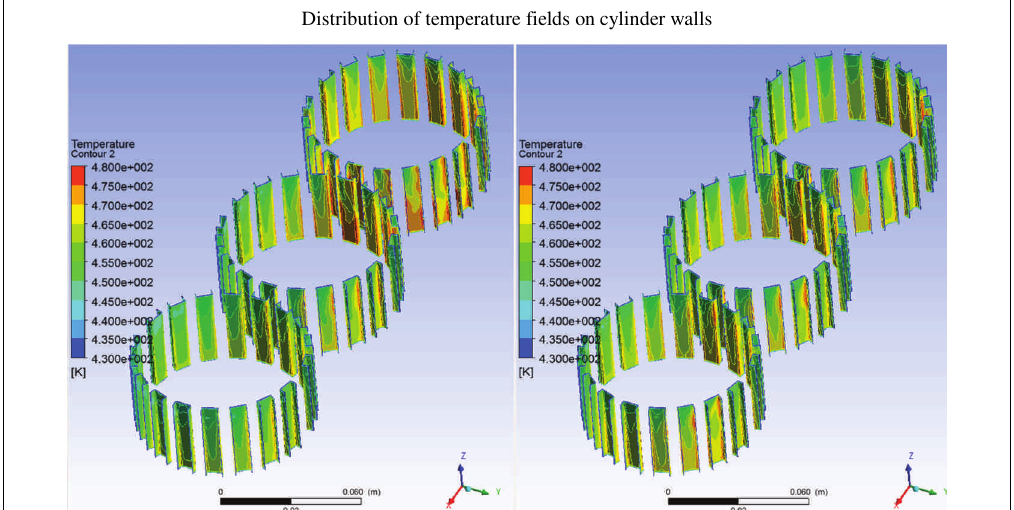
Fig. 13. Comparison of distribution velocity fields across the ribs and temperature fields for the basic model, one inlet and outlet (left side) and two inlets and outlets (right